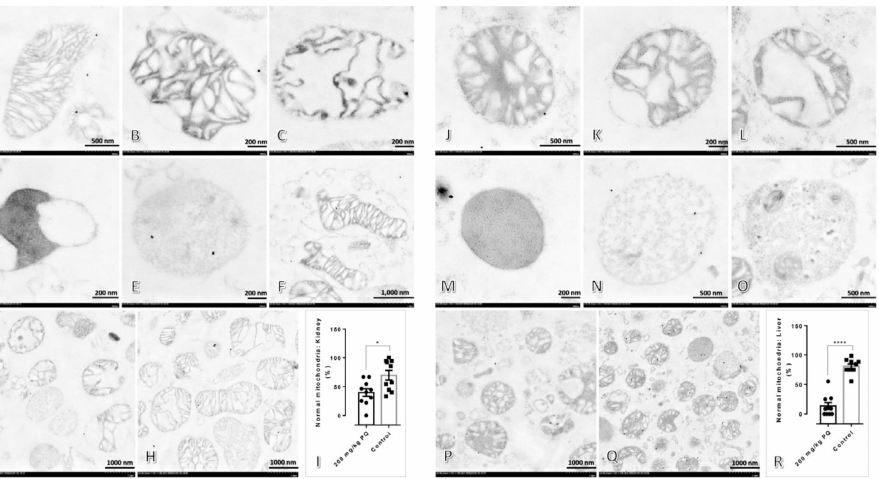
Figure 2. Electron micrographs of kidney and liver mitochondria in rats treated with or without 200 mg/kg of PQ: ( A – F ) Renal mitochondrial ultrastructure in six different forms: normal mitochondrion with double membrane and typical arrangement of cristae and matrix ( A ), swelling mitochondrion